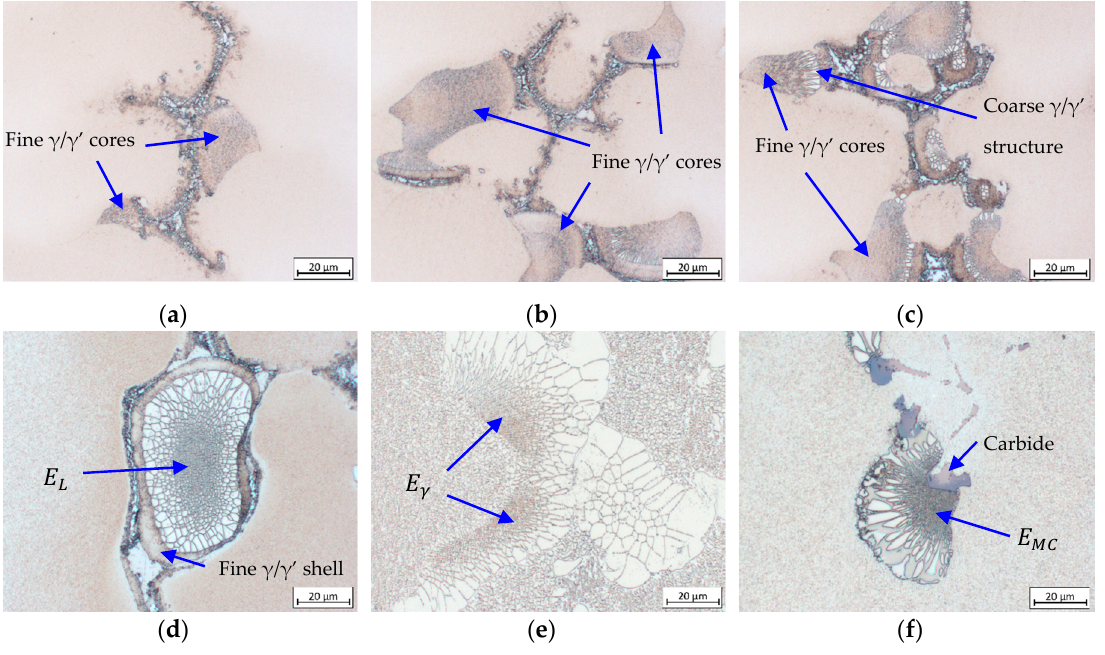
Figure 9. γ / γ ’ eutectic formation: ( a – c ) formation sequence observed in LC-MZ sample of CMSX-6 (W4)